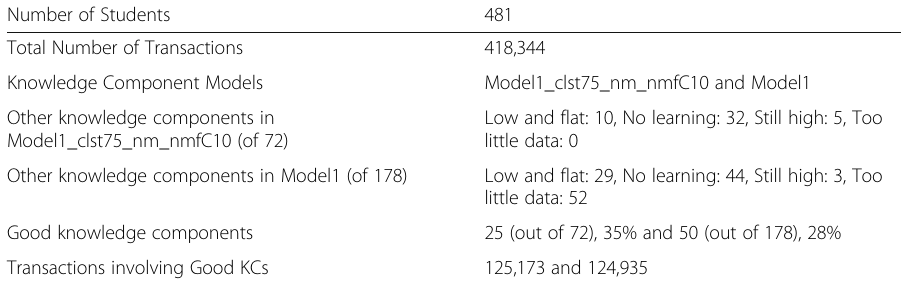
Table 8 Biology course data summary Number of